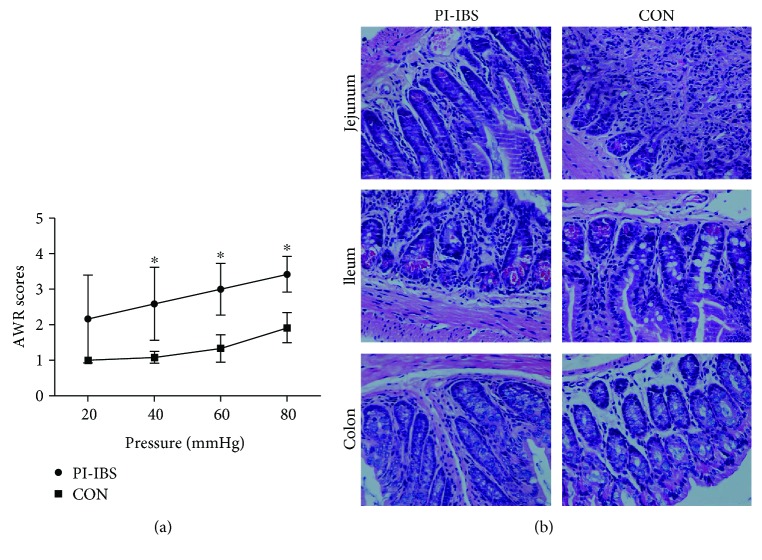
Relationship between AWR scores and histology in PI-IBS and control mice. (a) AWR scores to CRD. AWR scores at distention pressures of 40, 60, and 80 mmHg were significantly higher in PI-IBS mice than in control mice. (b) Hematoxylin and eosin (H&E) staining: representative sections of jejunum, ileum, and colon from PI-IBS or control mice (original magnification ×200). No evidence of inflammation, including neutrophil infiltration in the lamina propria or edema in interstitial tissues, was seen with PI-IBS mice compared with control mice. ∗p < 0.05 versus control.